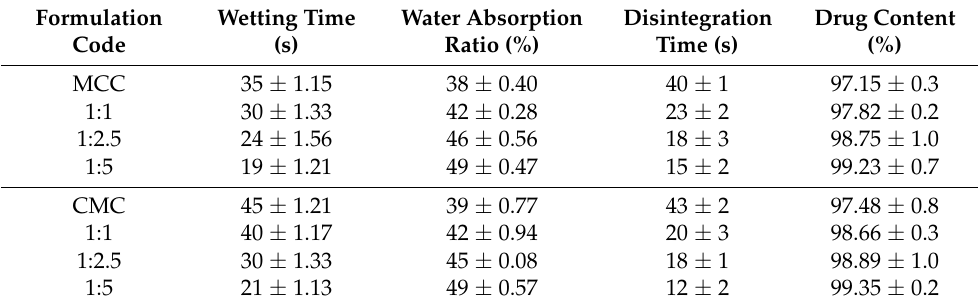
Table 7. Values depicting the wetting time, water absorption ratio, disintegration time and drug content of the prepared MCC-SiO 2 FDTs, Values depicting the wetting time, water absorption ratio, disintegration time and drug content of the prepared CMC-SiO 2 FDTs.